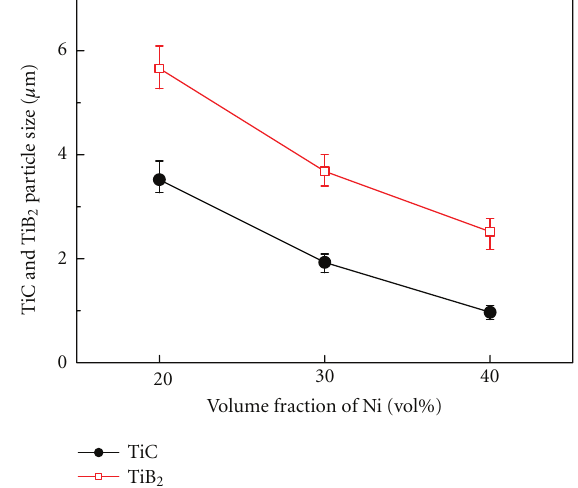
Figure 9: Relationship between T ad and Ni volume fraction of samples with a TiC/TiB 2 volume ratio of 3/1.